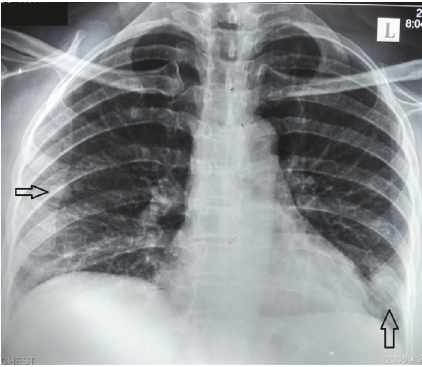
Figure 1: Bilateral multiple opacifications in chest radiograph.